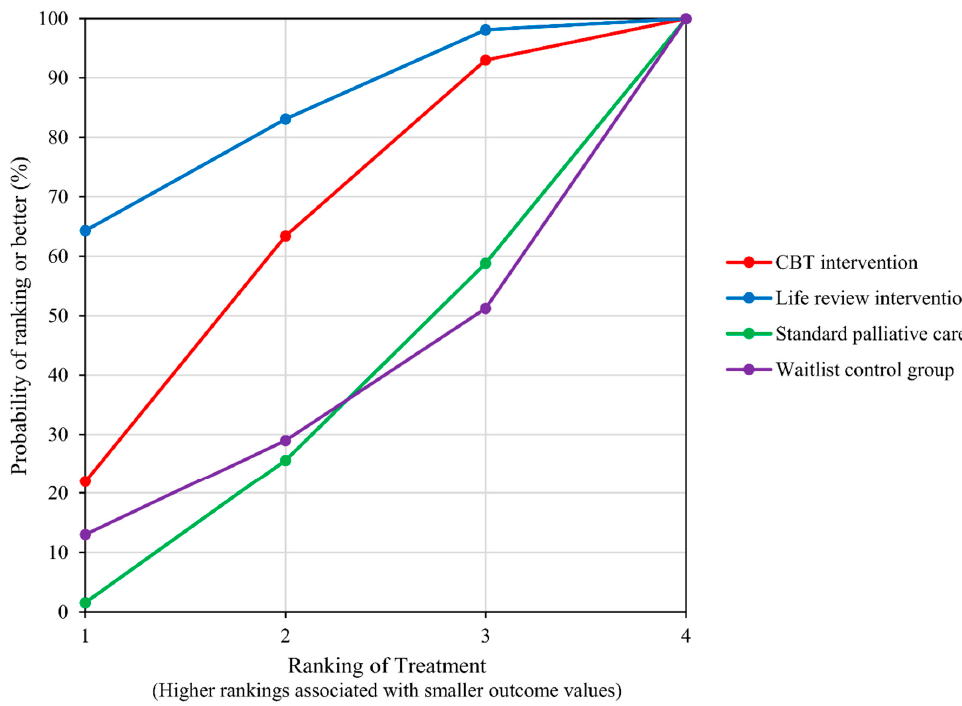
Figure 3. SUCRA Plot for outcome of HADS total.